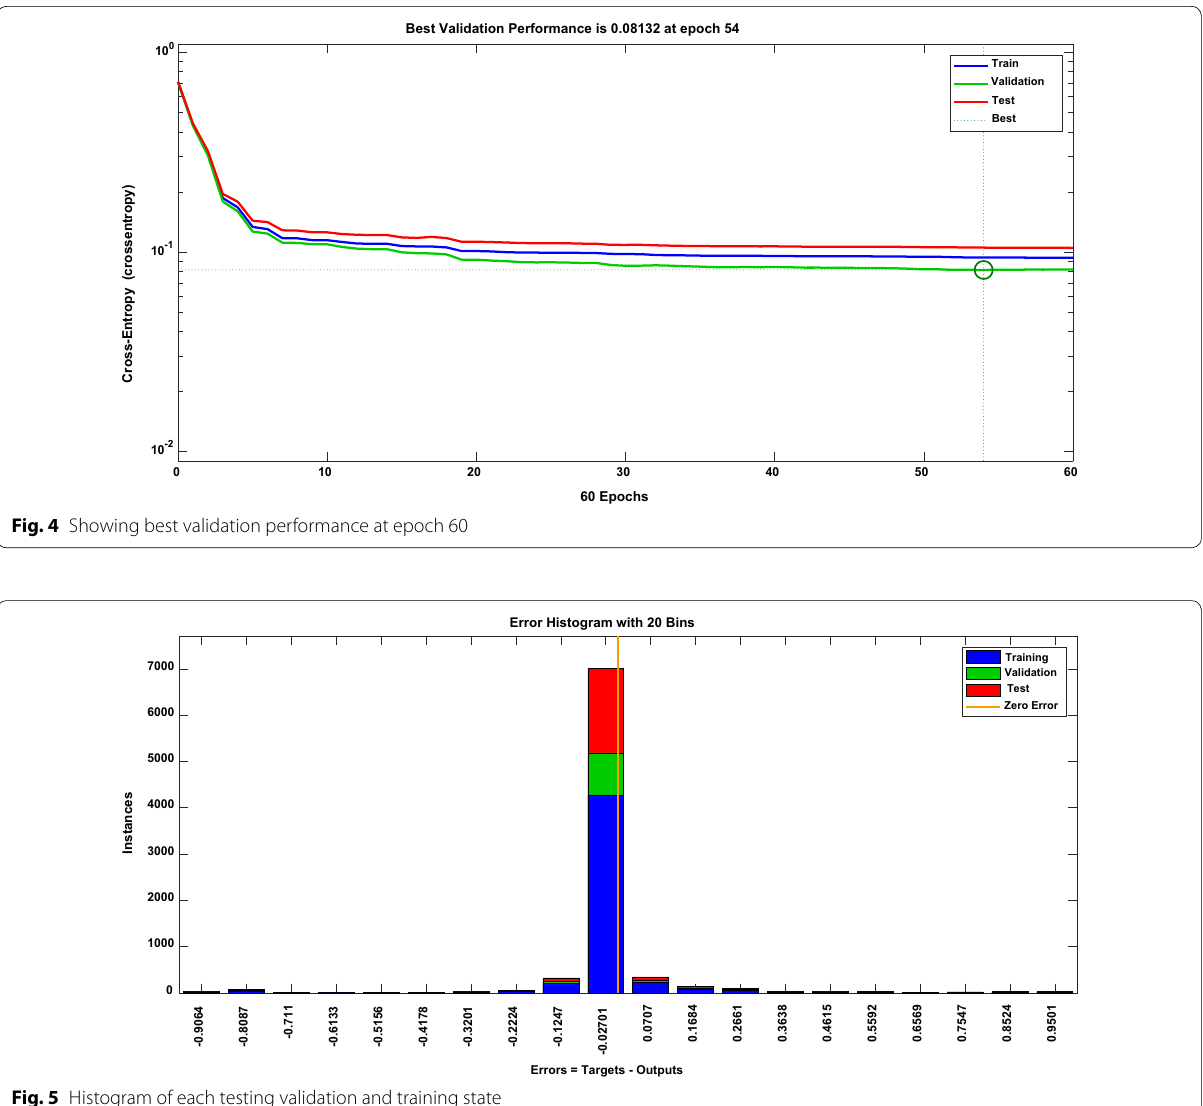
Fig. 5 Histogram of each testing validation and training